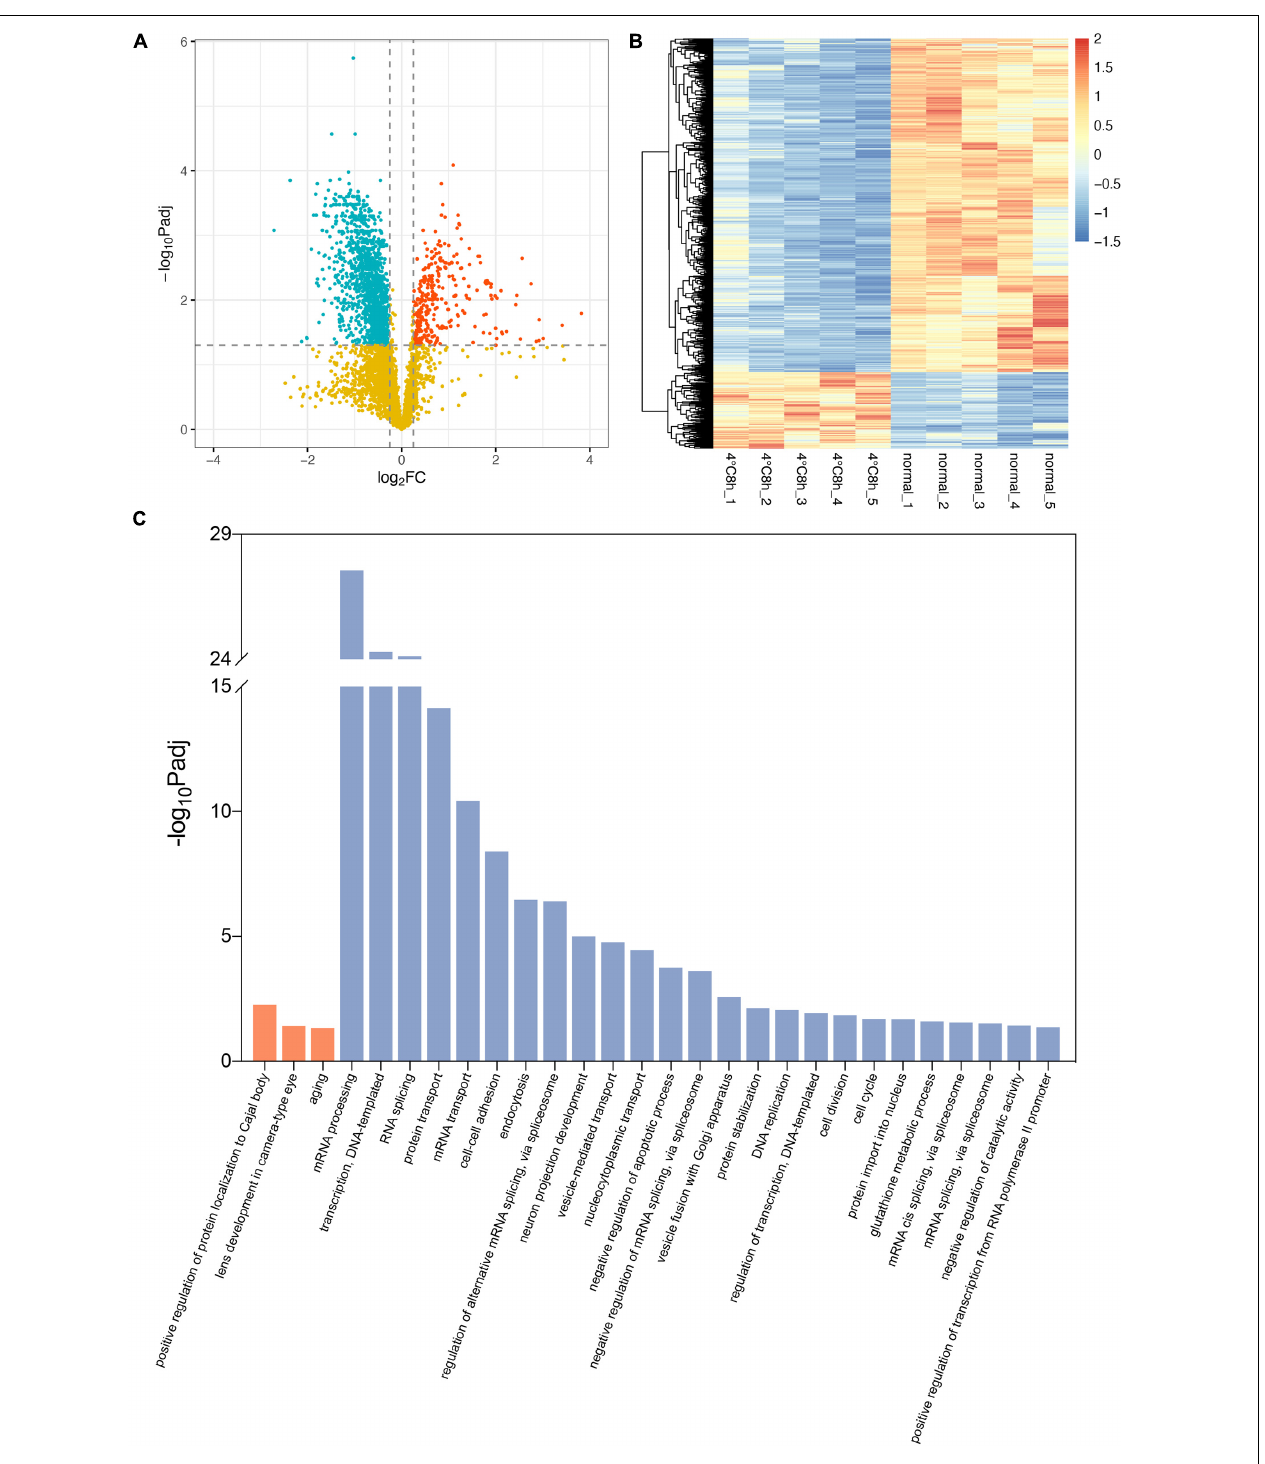
FIGURE 3 | Analysis of proteomic changes in cold treated lens capsules. (A) Volcano plots depict the log2FoldChange and statistical significance, with the adjusted P -value expressed as − log10(adjusted P -value). Red points, green points, and yellow points represent up-regulated genes, down-regulated genes, and non-differentially expressed genes, respectively. (B) Heatmap of differentially expressed proteins (DEPs) in the 10 samples. (C) Biological process in Gene ontology (GO) analysis for the up- and down-regulated DEPs. Terms in orange bars were enriched from up-regulated proteins and terms in blue bars were enriched from down-regulated